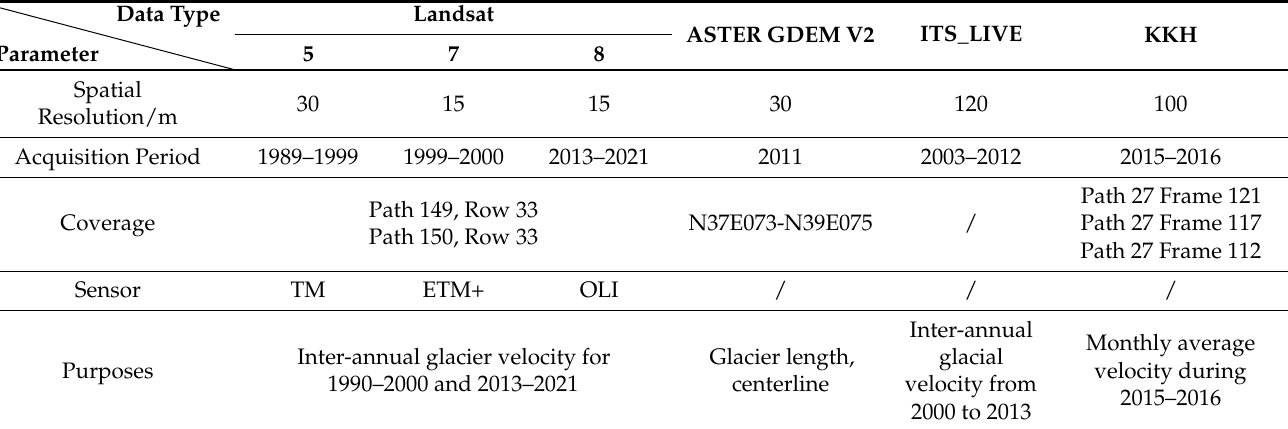
Table 1. Remote sensing data used in the present